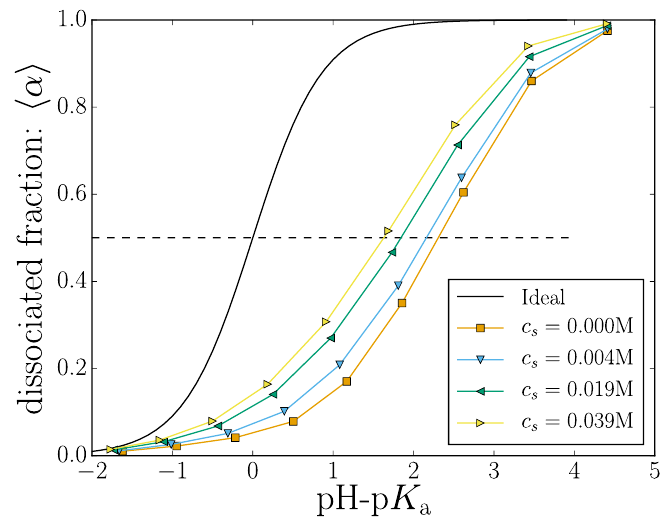
Figure 2. (Color online) Titration curve: The mean fraction of dissociated monomers versus pH-p K a . The different markers indicate different salt concentrations. The ideal titration curves is shown as a solid black line.